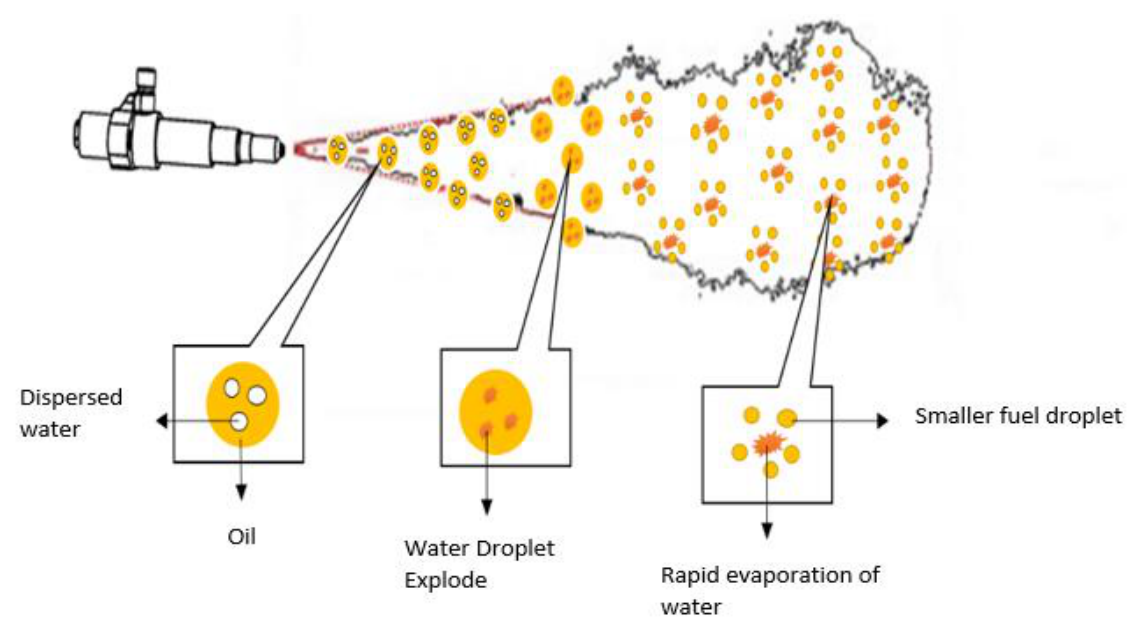
Figure 5. Atomisation of a dispersed system in